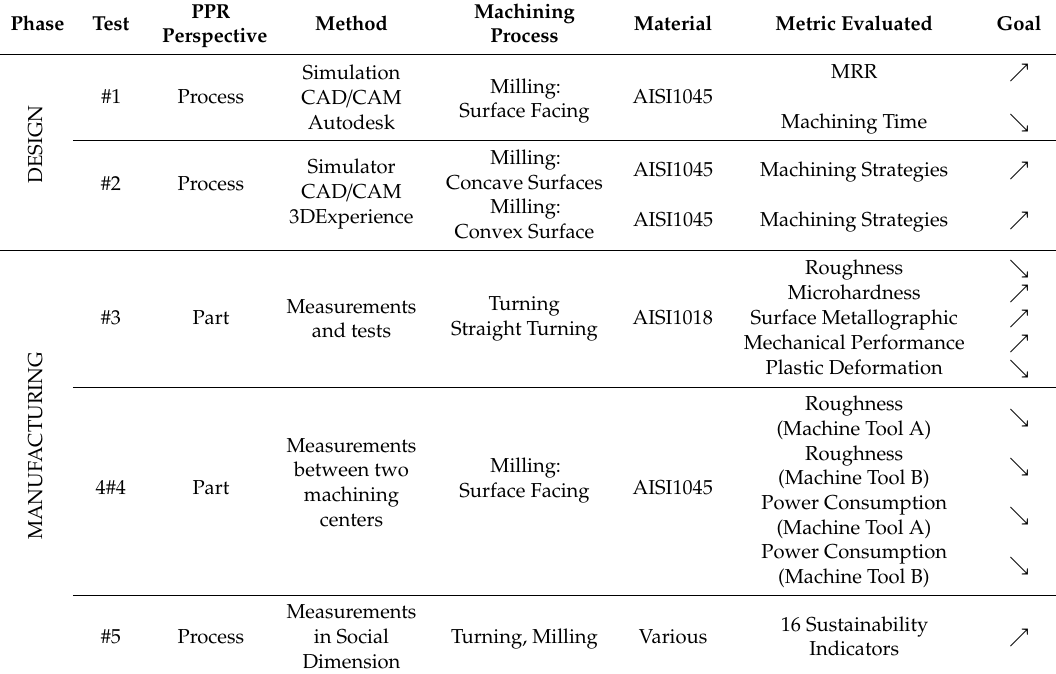
Table 9. Experimental validation of sustainable machining indicators. MRR: Material Removal